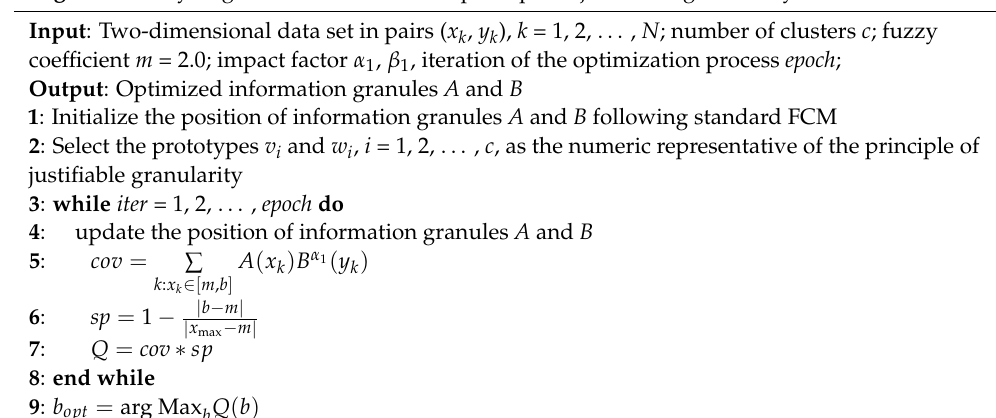
Algorithm 1: Synergistic mechanism of the principle of justifiable